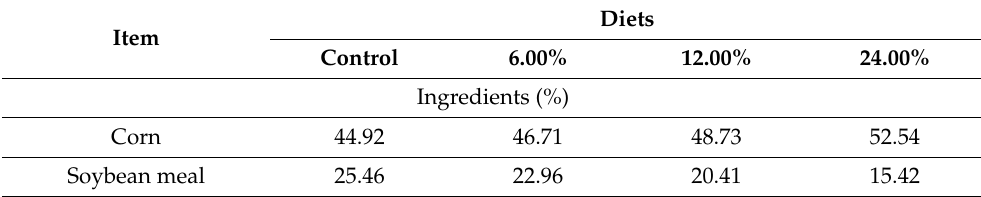
Table 1. Composition and nutrient levels of the basal diets (air-dry basis,